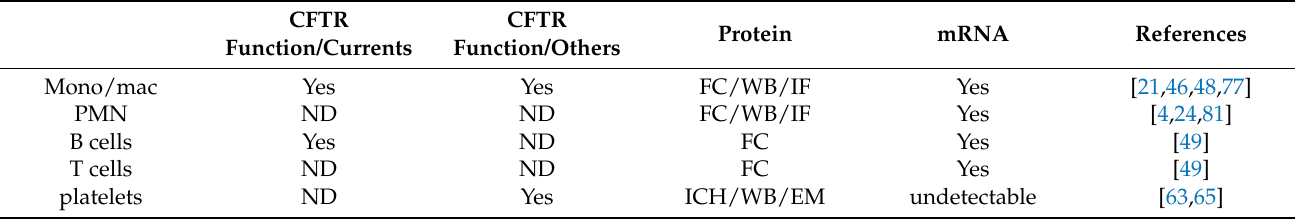
Table 1. Summary of data supporting CFTR expression in leukocytes. FC: flow cytometry, WB: western blotting, IF: immunofluorescence; EM: electron microscopy; ND: not